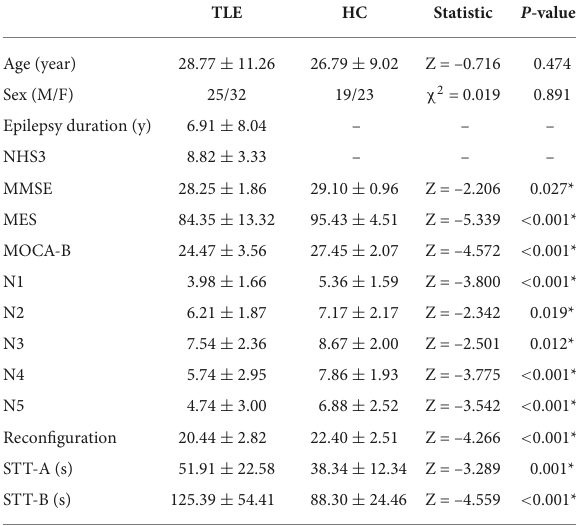
TABLE 1 Demographic, clinical, and neuropsychological